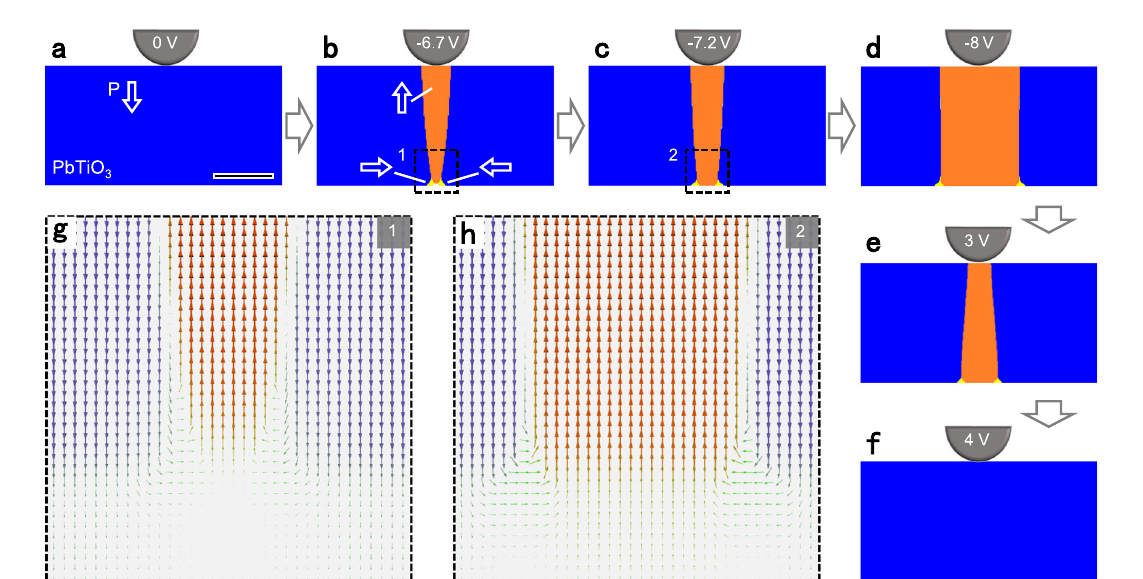
Fig. 4 | Phase- fi eld simulations of electric- fi eld control of nucleation and motion of isolated threefold vertices. a The initial state of the PbTiO 3 fi lm with downward polarization. A voltage bias can be applied at the top surface of the PbTiO 3 fi lmthroughametaltip.Whitearrowindicatesthedirectionofpolarization. Scale bar, 50nm. b The isolated threefold vertices nucleate when the upward domain reaches the interface. c , d Isolated vertices move away from each other